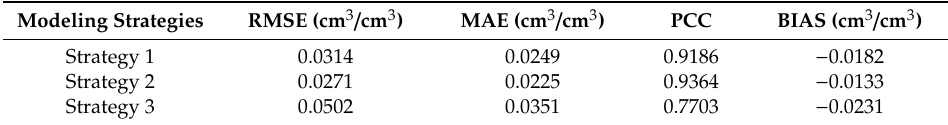
Table 9. RMSE, MAE, PCC, and bias between the measured and estimated soil moisture based on the validation